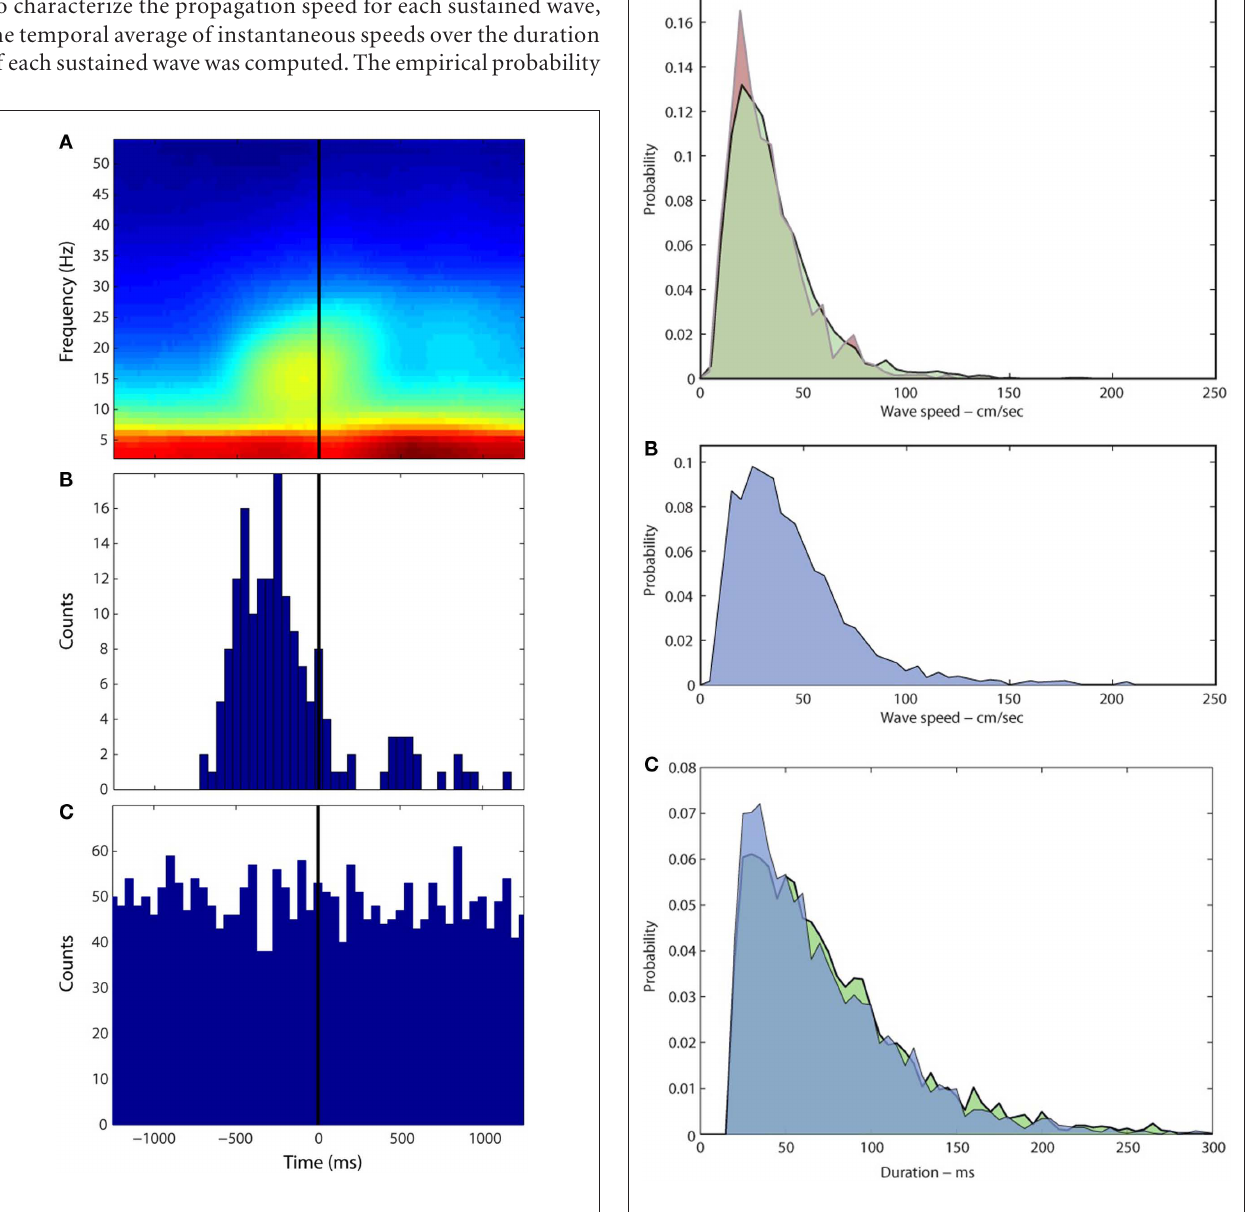
Figure 3 | Distributions of sustained wave speeds and durations. (A,B) Normalized distributions of sustained wave mean speeds under both conditions. (A) Light Green: Engaged condition; Pink: Resting condition for the human subject (B) Light Blue: NHP subject for Engaged condition only. (C) Distributions of sustained wave durations Green: The human subject, Blue: